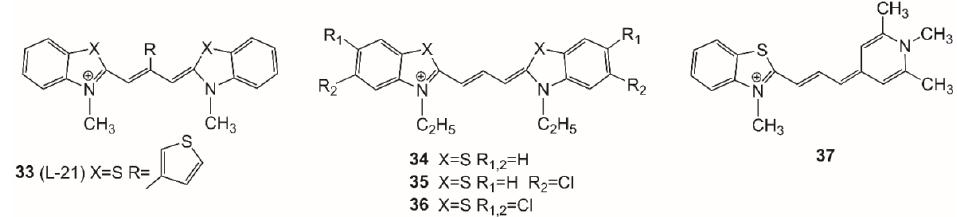
Figure 9. Structures of cyanines 33 – 37 .